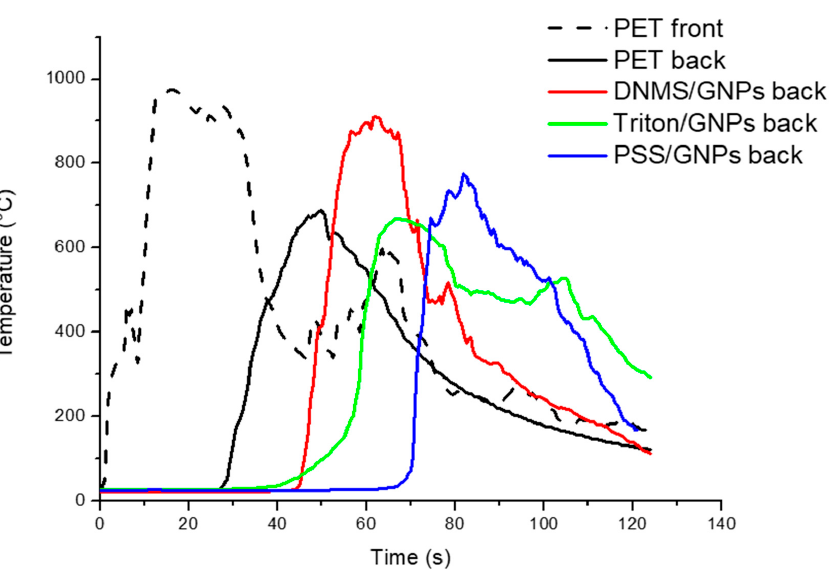
Figure 4. Flame penetration curves of samples with an exposed side covered by GNPs coating with solutions of DNMS, Triton, and PSS dispersants.